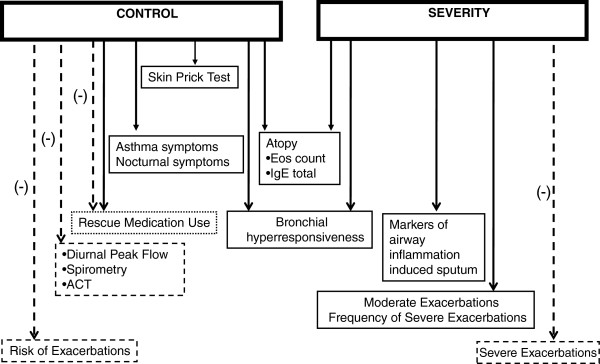
Role of FeNO as a marker of asthma control and severity. The continuous lines indicate the evidence of relationship between FeNO and several markers of asthma controls; the dashed lines indicate no evidence.